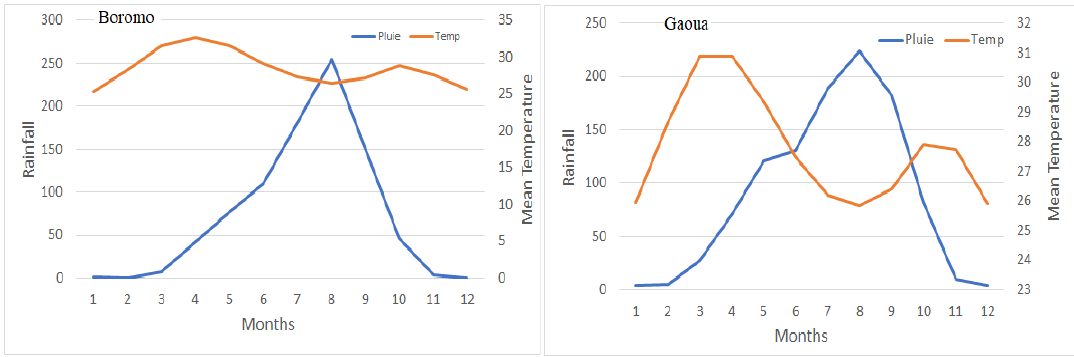
Figure 2. Rainfall and temperature at Boromo and Gaoua climatic stations.